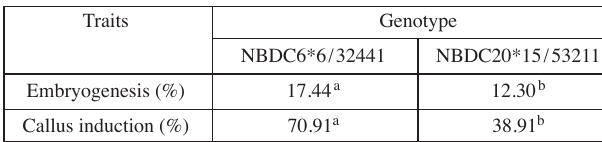
Tab. 3: Effects of genotypes on callus and embryo induction in experiment 2.